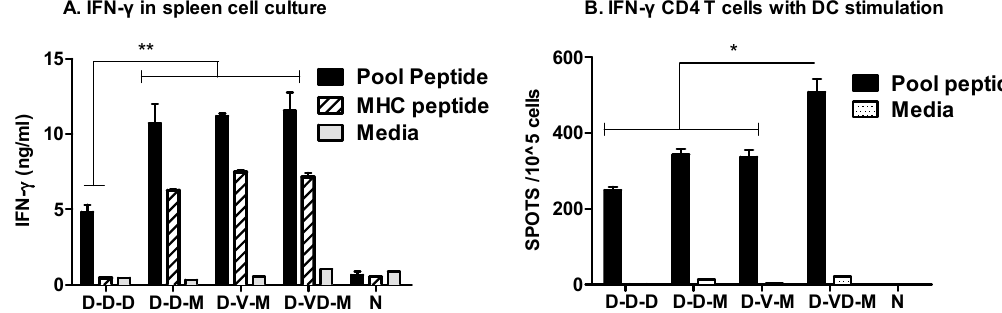
Figure 4. IFN- γ production from spleen cells or IFN- γ + spots of CD4 + T cells in vitro. ( A ) IFN- γ production from spleen cell cultures. IFN- γ cytokine levels in spleen cell (1 × 10 6 ) culture supernatants were determined by using cytokine ELISA after stimulation with a pool of peptides or MHC I restricted peptide; ( B ) IFN- γ secreting spots in CD4 T cells + DC cultures. CD4 + (1 × 10 5 ) T cells (purified from spleen cells) in the presence of DCs (1 × 10 4 ) loaded with a pool of peptides were plated in 96 well ELISPOT plates coated with anti IFN- γ antibodies in triplicates. Spleen cells were collected at 14 days after second boost. Groups are the same as described in the Figure 2 legend. **: p < 0.01, *: p < 0.05 between the comparing groups in the pooled peptides after second boost.